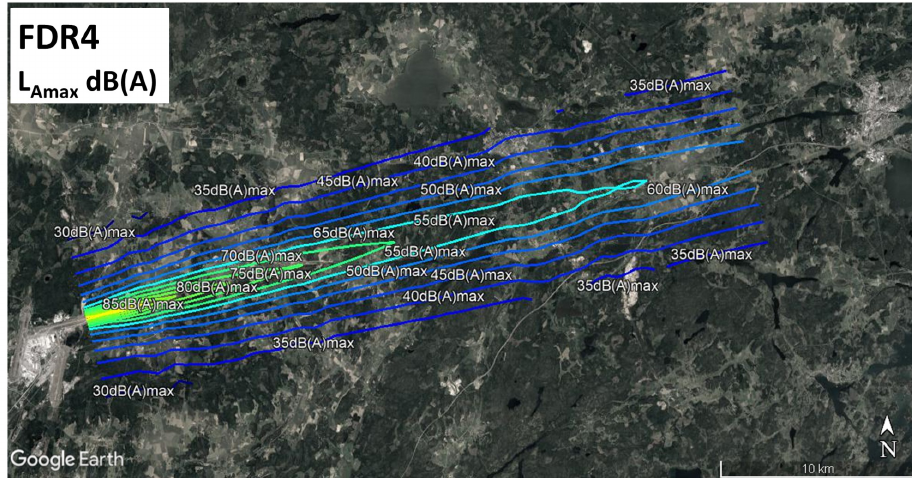
Figure 11. Noise prediction for FDR4 computed with SAFT ECAC Doc 29